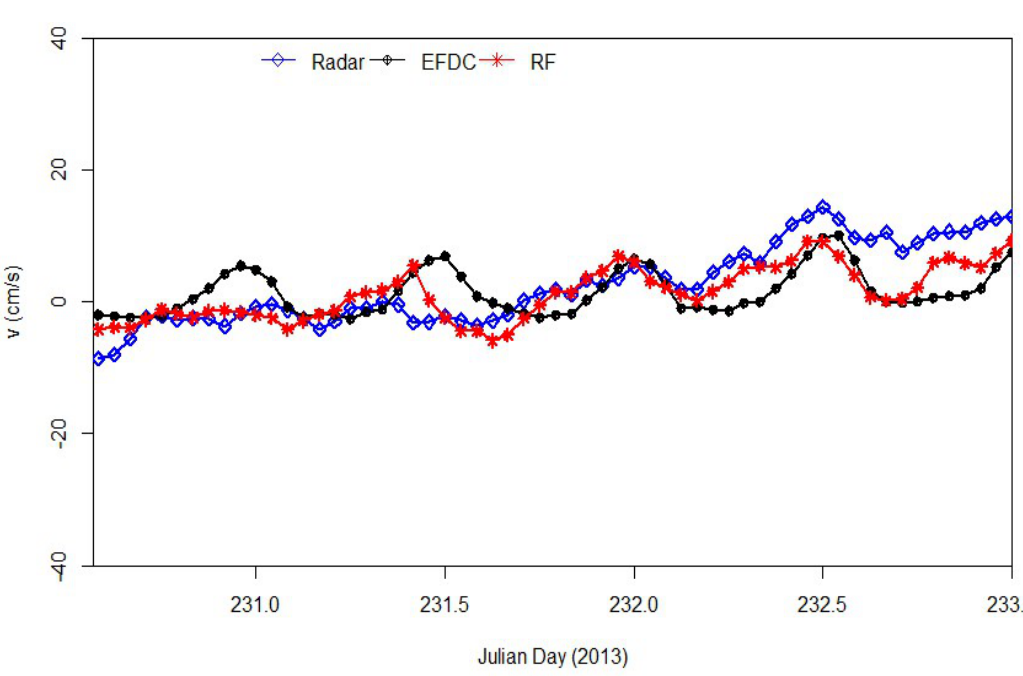
Figure 8. Predictions of meridional surface velocity component at point Figure 7. Predictions of zonal surface velocity component at point P3.